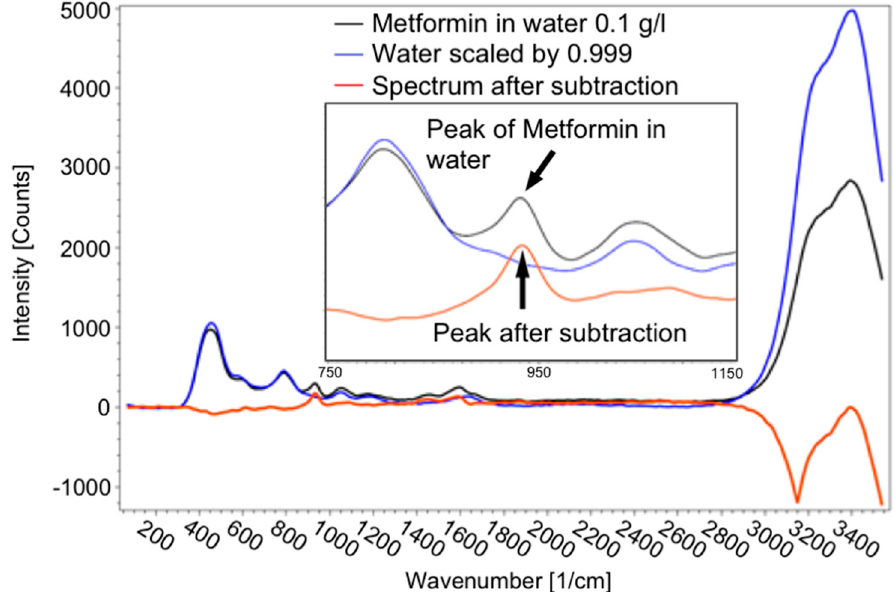
Figure 10. Spectrum of 0.1 g metformin hydrochloride in 1 l water (black line), spectrum of scaled water (blue line) and spectrum after subtraction of the spectrum of water from the solution (red line), as well as a detailed view of the peak of metformin hydrochloride to determine the concentration.